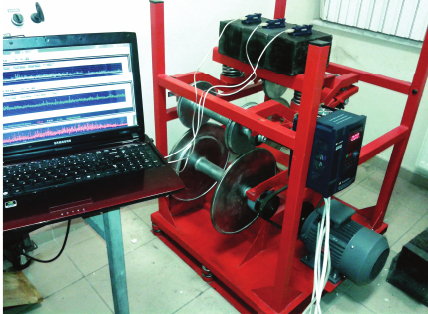
Figure 5: Real-time simulation of the bogie-bridge interaction on 1: 5 scaled roller